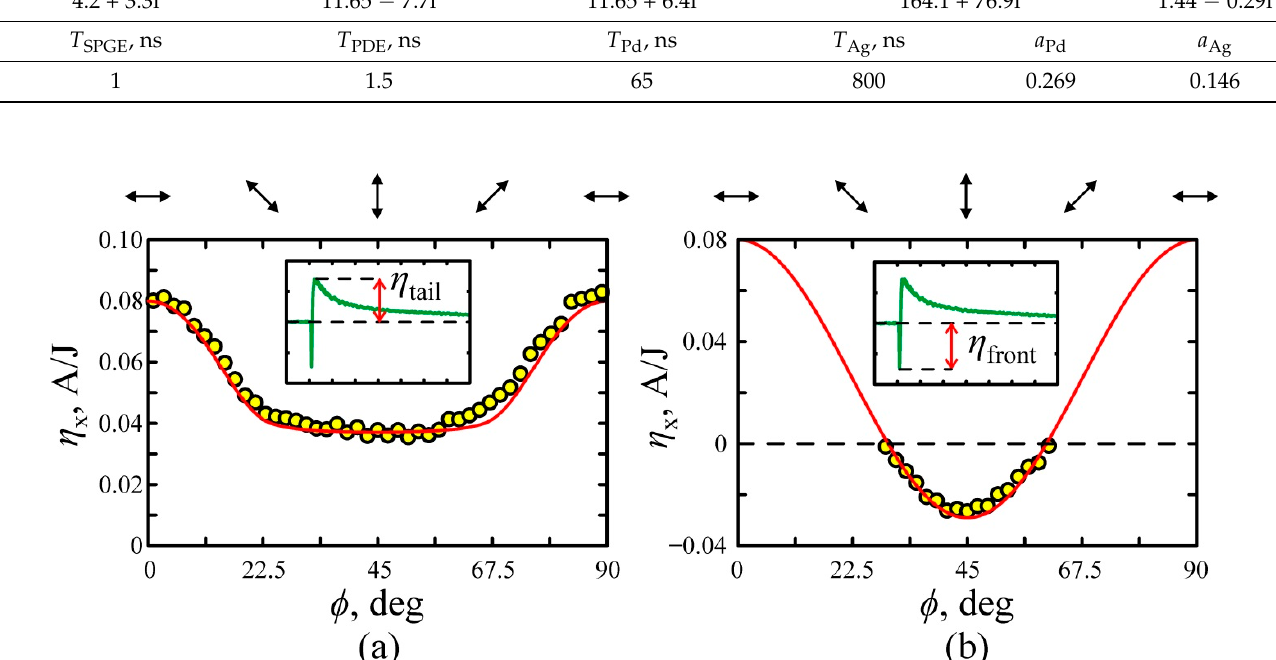
Figure 6. The dependences of the longitudinal conversion efficiency on the half-wave plate orientation ϕ for the ( a ) tail and ( b ) front parts of the photocurrent pulses. The circles represent the experimental data, while red lines correspond to approximation by Equations (23) and (24) with parameters given in Table 1. Arrows at the top of ( a ) and ( b ) show orientation of the polarization azimuth of the excitation beam. Insets to ( a,b ) show temporal profiles of the photocurrent pulse.